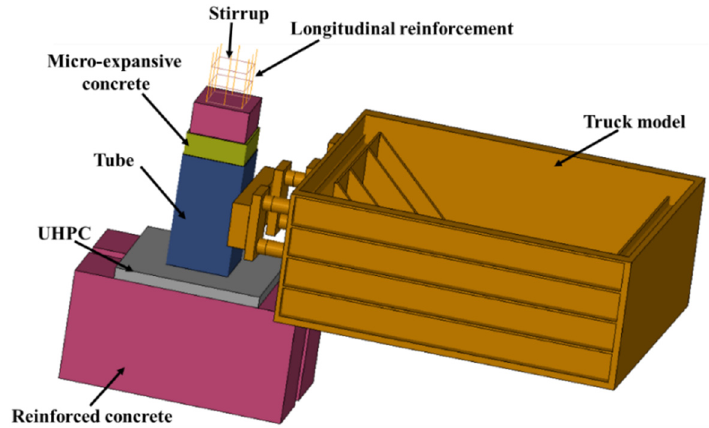
Figure 10. Schematic of finite element model.